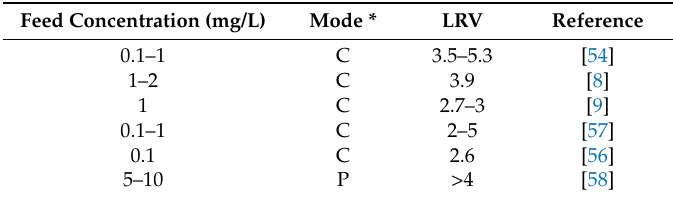
Table 2. Summary of reported RWT integrity